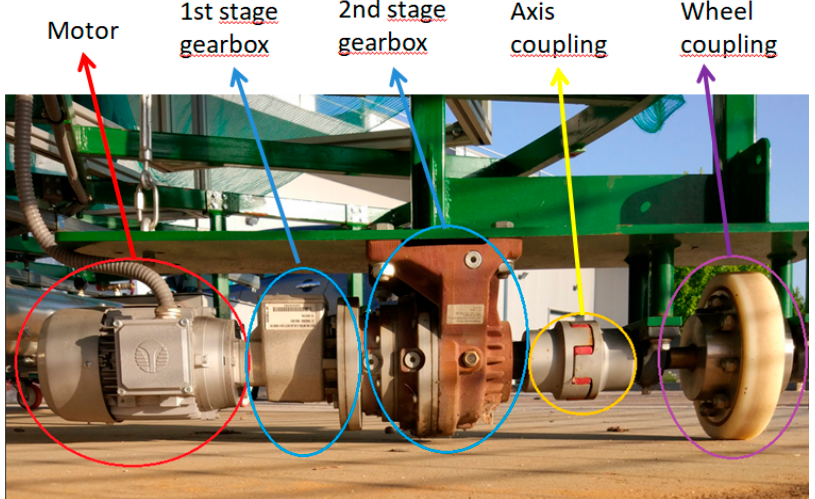
Figure 20. Complete traction unit detail. Two-stage gearboxes with an 1883 5:1 reduction ratio, giving an output torque of 1893 Nm.